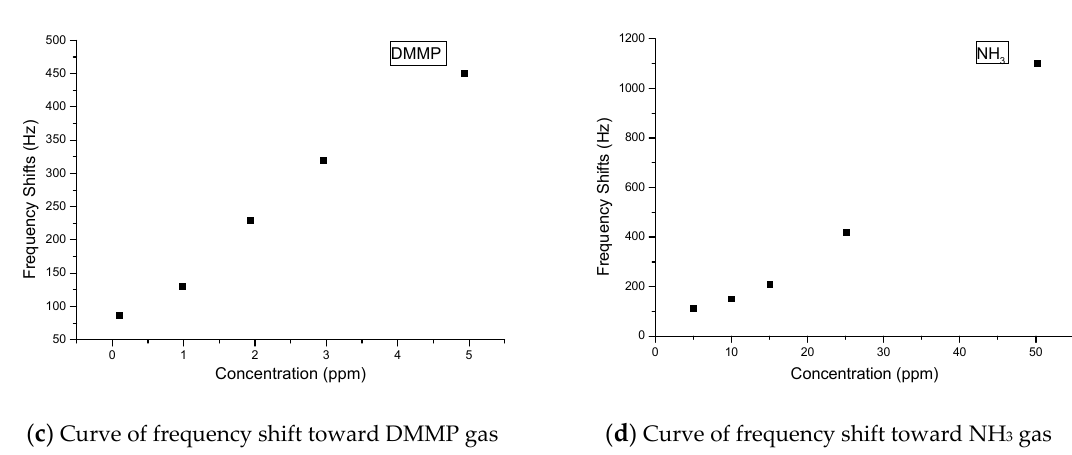
Figure 5. Response of the SAW sensor array to different concentration gases.